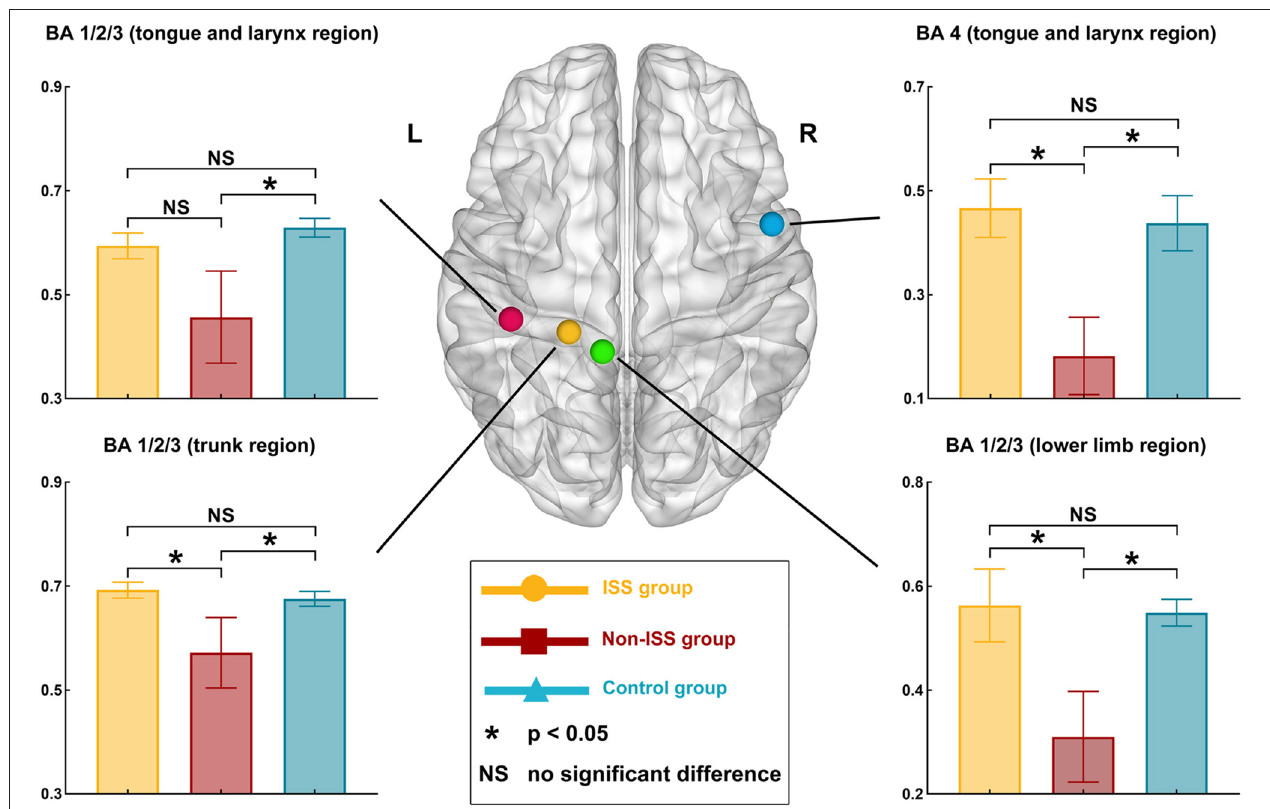
FIGURE 4 | Alterations in nodal efficiency in the ISS, non-ISS, and healthy groups. ISS, group of patients with intraoperative stimulation-induced seizures; Non-ISS, group of patients without intraoperative stimulation-induced seizures. is strong. Hence, these results indicated that gliomas